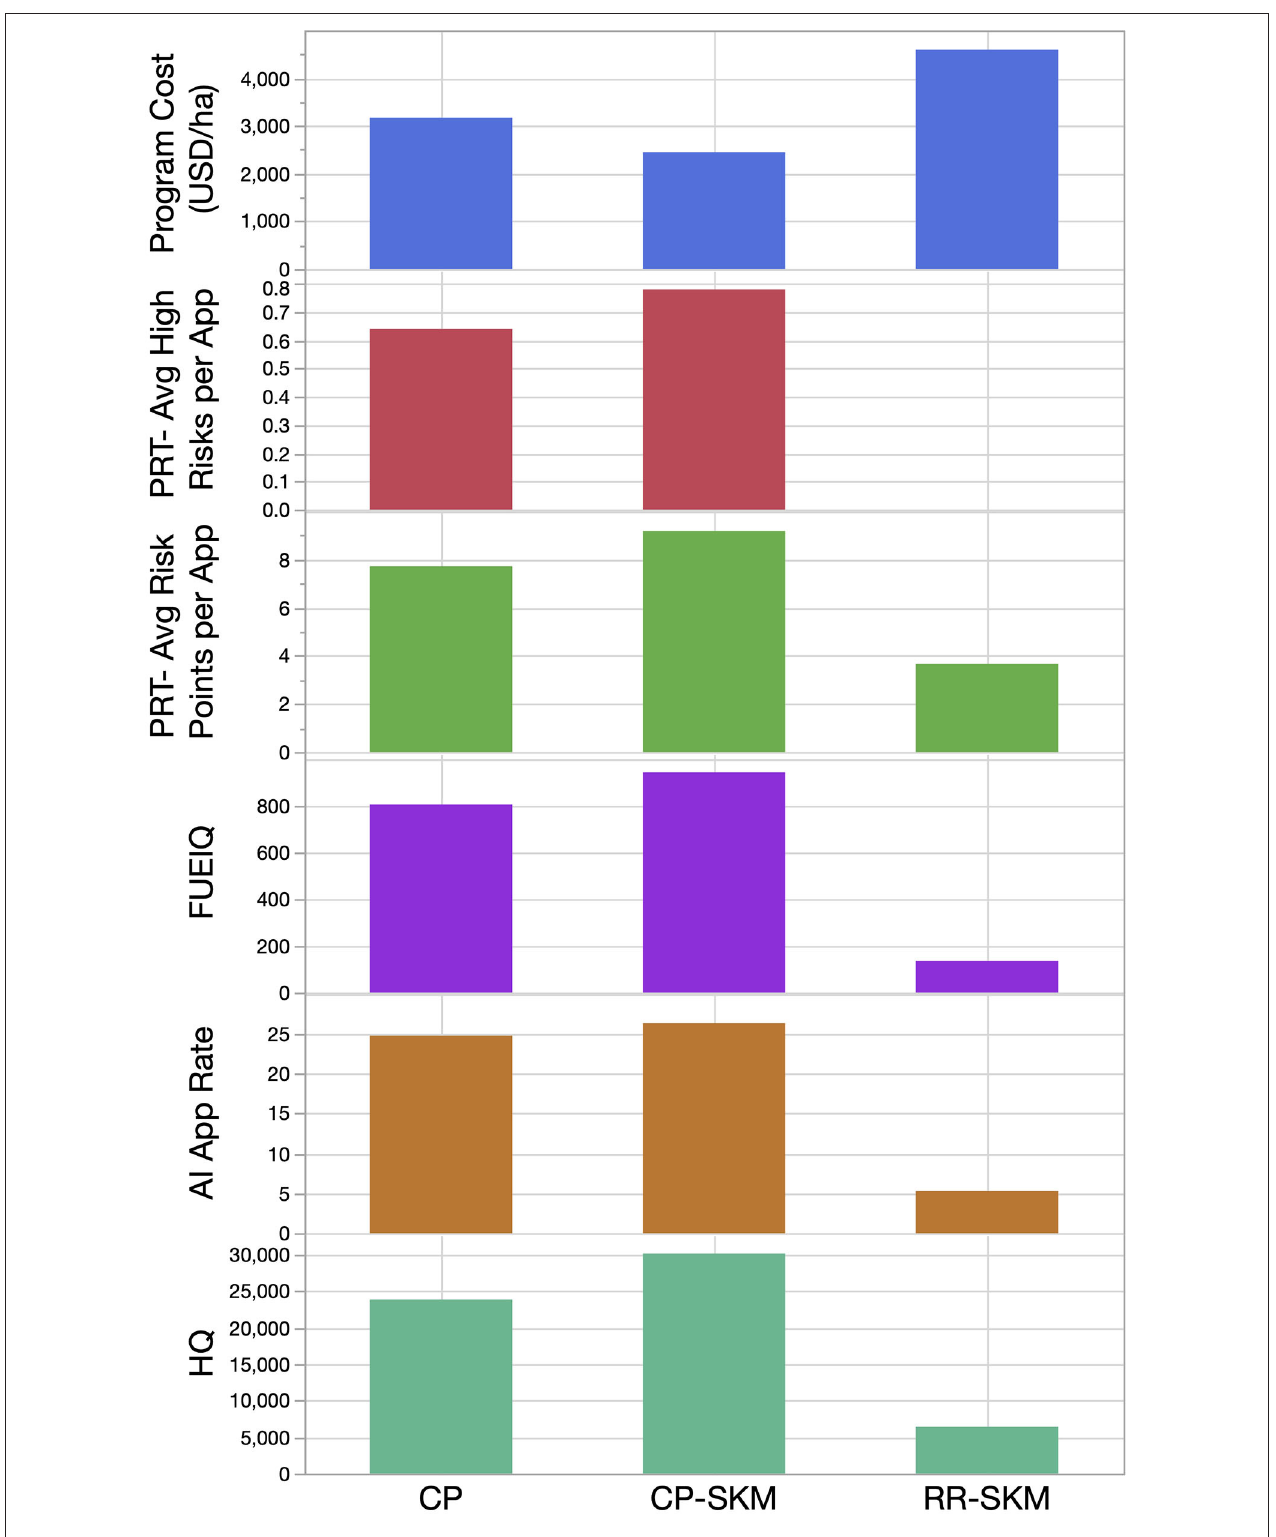
FIGURE 1 | Pesticide risk and price of each treatment program in the Smith Kerns Model Reduced Risk Study according to the five pesticide risk indices used to quantify pesticide risk: HQ, Hazard Quotient; AI App Rate, Active Ingredient Application Rate; FUEIQ, Field Use Environmental Impact Quotient; PRT-Risk Points per App, Pesticide Risk Tool- Risk Points per Application; PRT-High Risks per App, Pesticide Risk Tool- High Risks per Application. The treatment programs were the control, Conventional Program (CP), Conventional Program Smith-Kerns Model (CP-SKM), and Reduced Risk Smith-Kerns Model (RR-SKM).